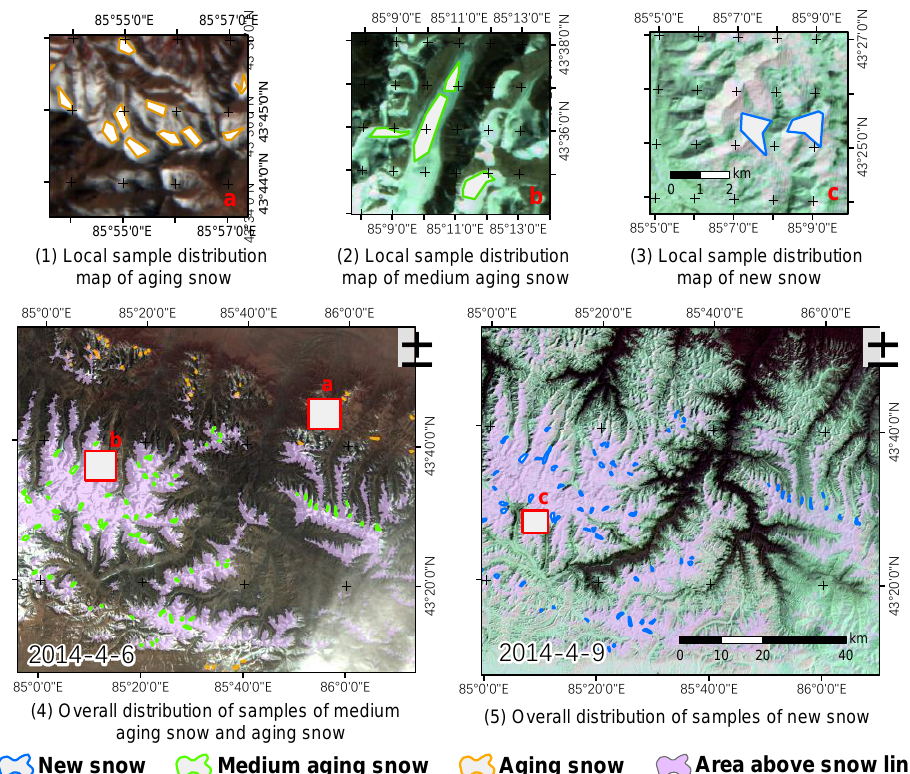
Figure 5. Comparison of snow cover of HJ-1A / B image pair on 6 and 9 April 2014, the snowline altitude targeting zones, and the distribution of three types of snow-aging training samples.